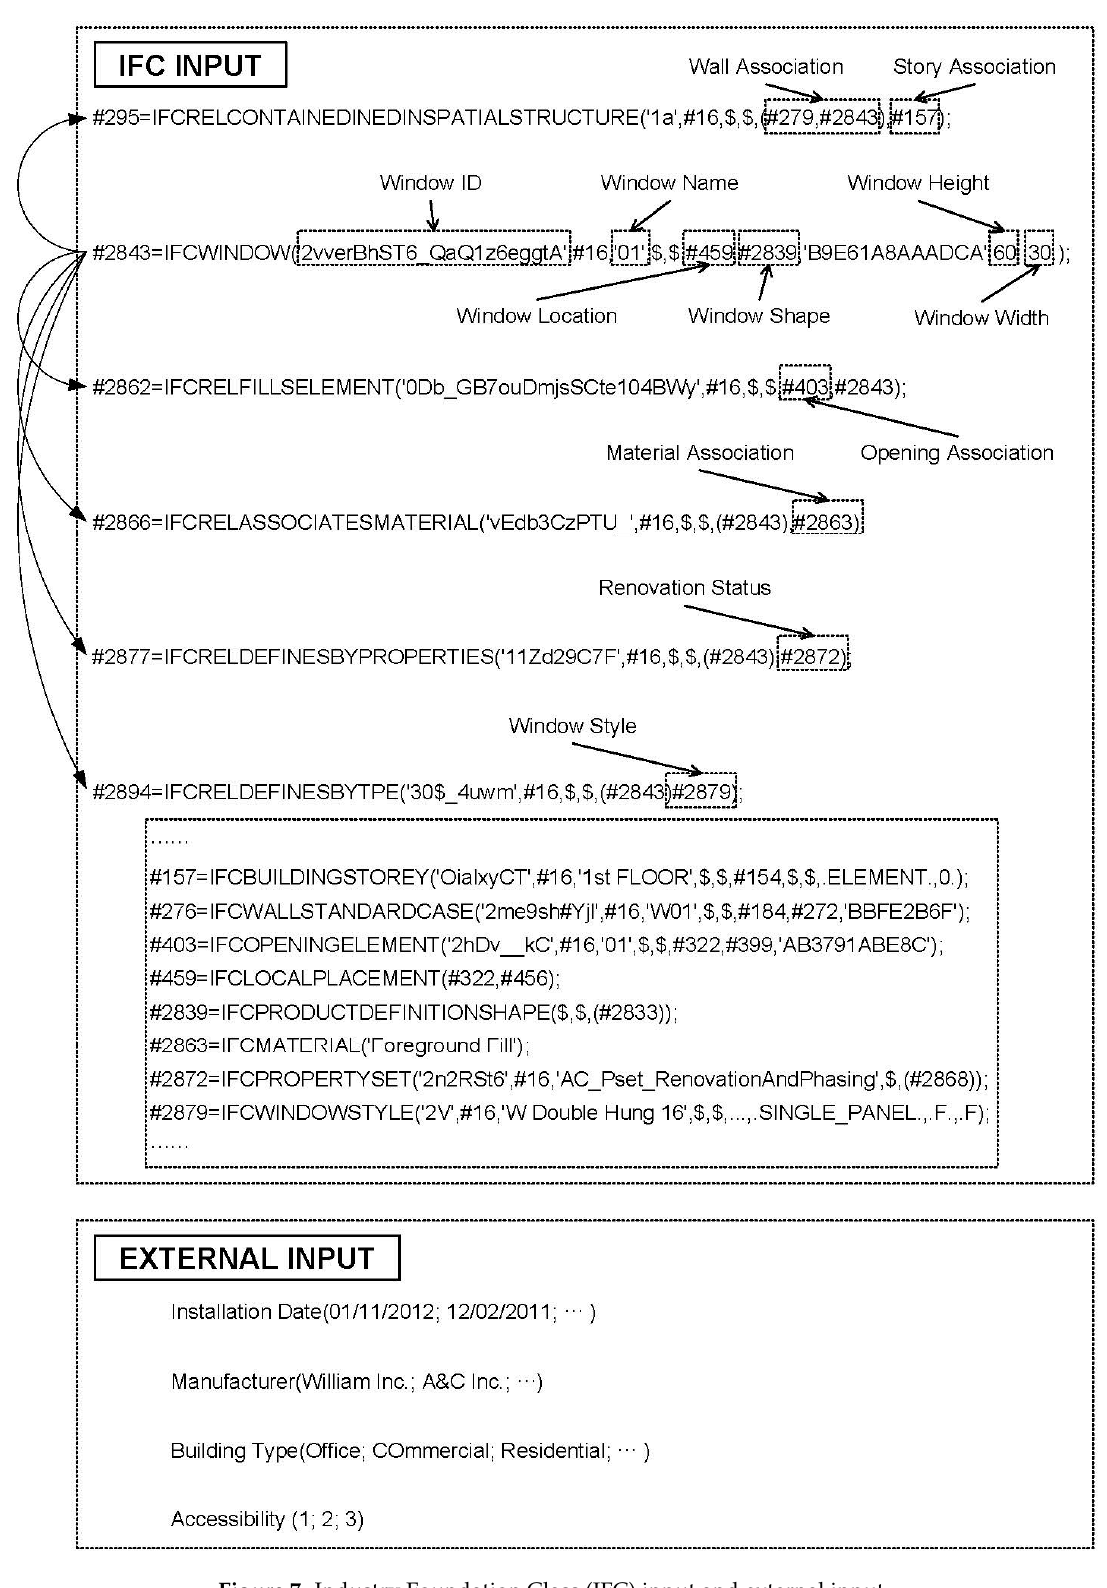
Figure 7. Industry Foundation Class (IFC) input and external input.